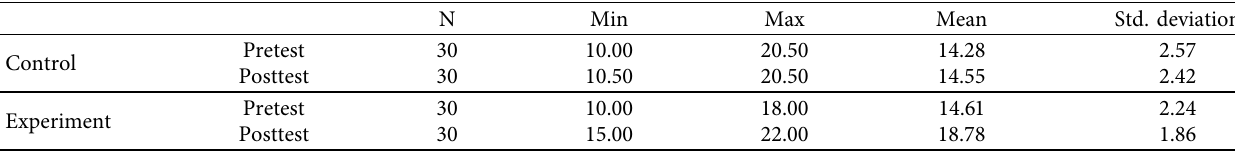
Table 13: Descriptive statistics for writing skill in upper-intermediate